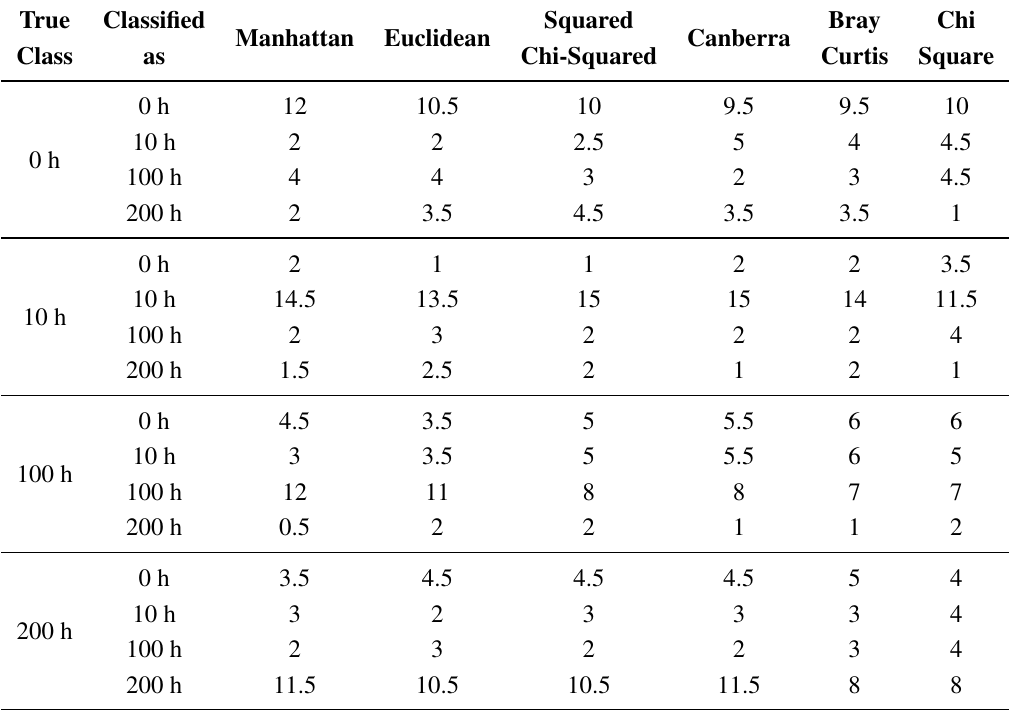
Table 9. Confusion matrix of the classification means for the 4-MHz frequency pulse echo signals at 950 ◦